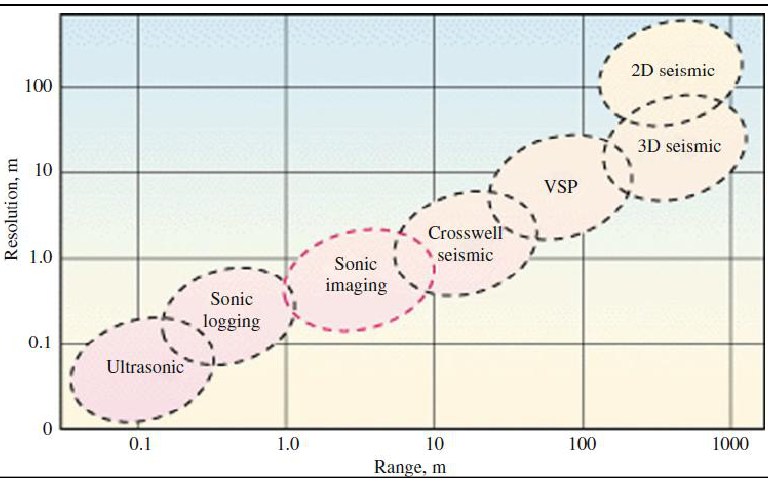
Figure 2—Range versus resolution of various geophysical techniques (Chabot et al.